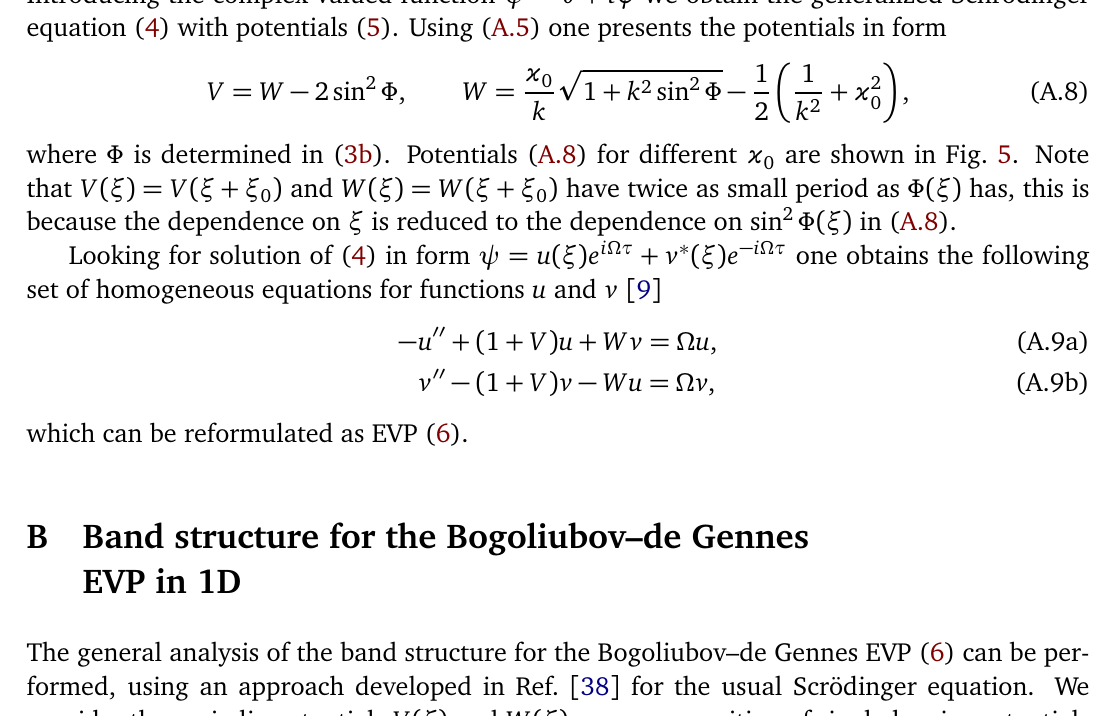
. Dashed 0 = 3, respec- 0